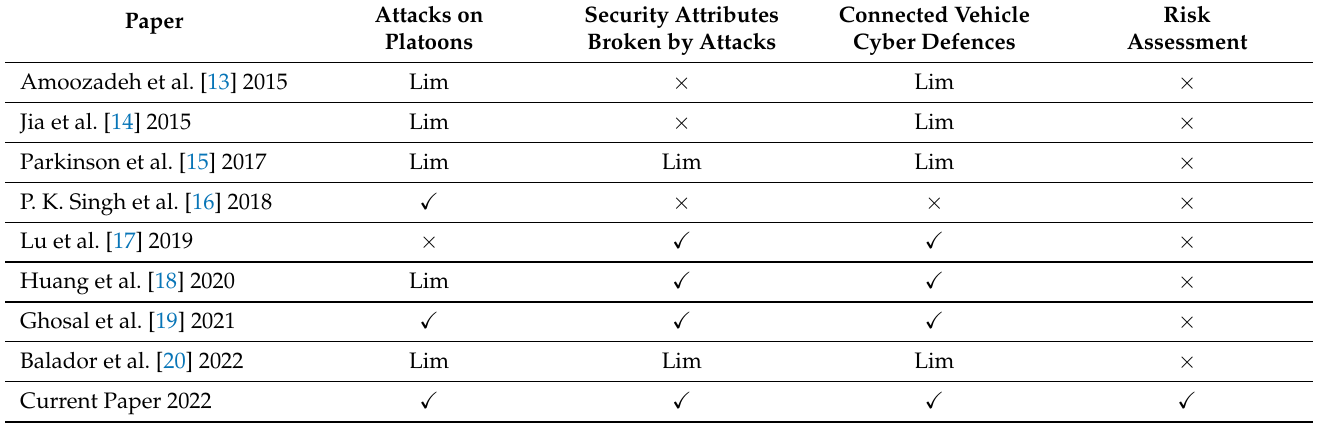
Table 1. Related surveys addressing cybersecurity of Platoons, CAV, and VANETs. A detailed discussion of a topic is denoted with a (cid:88) , No discussion uses a × and limited discussion is